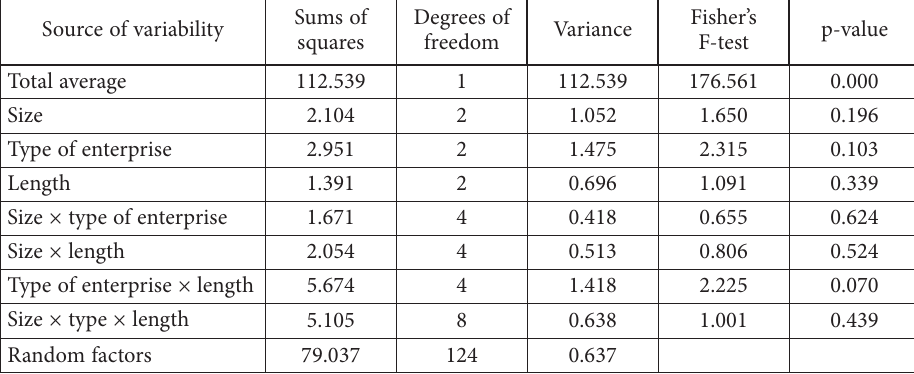
Table 3. Three-factor analysis of variance